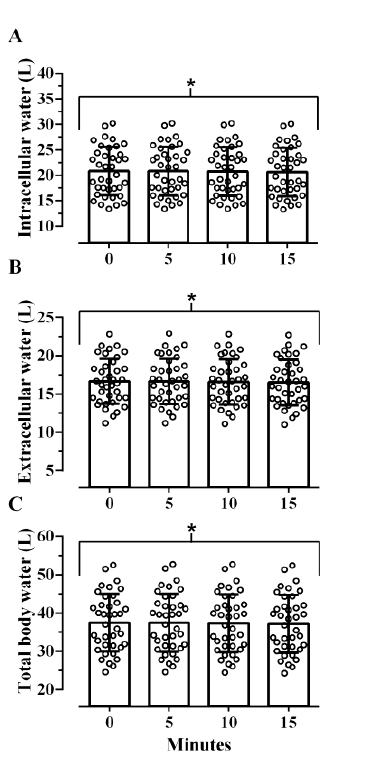
Fig. 2: Effect of time since transitioning from a vertical to a supine position on intracellular water (A), extracellular water (B), and total body water (C) over 15 minutes as assessed via the RJL Quantum Legacy analyzer (N=38). Open circles represent individual responses. *Denotes a statistically significant decrease from baseline over the course of 15-minutes resting in a supine position (p<0.05).